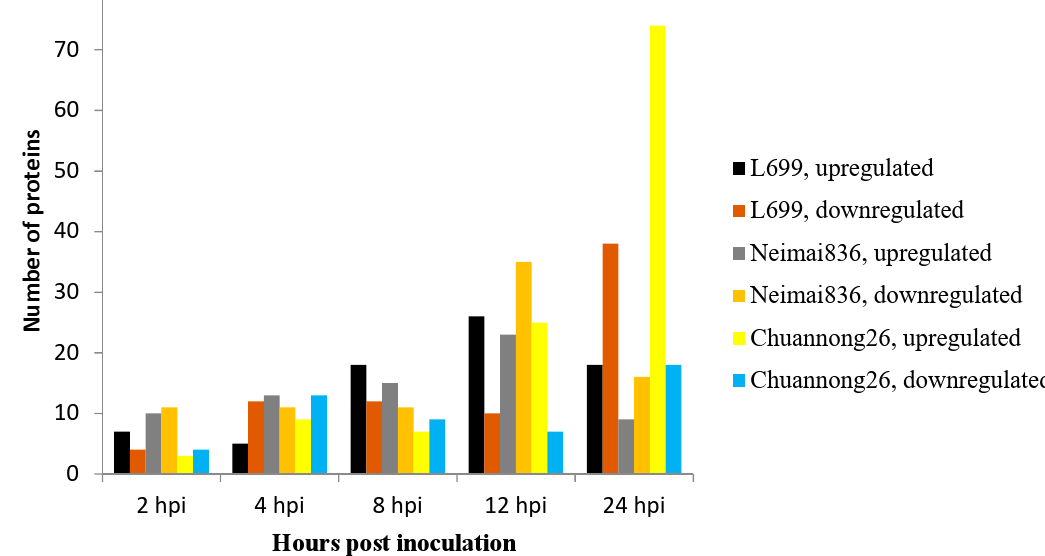
Figure 3. Number of proteins differentially expressed after powdery mildew infection at different time points.